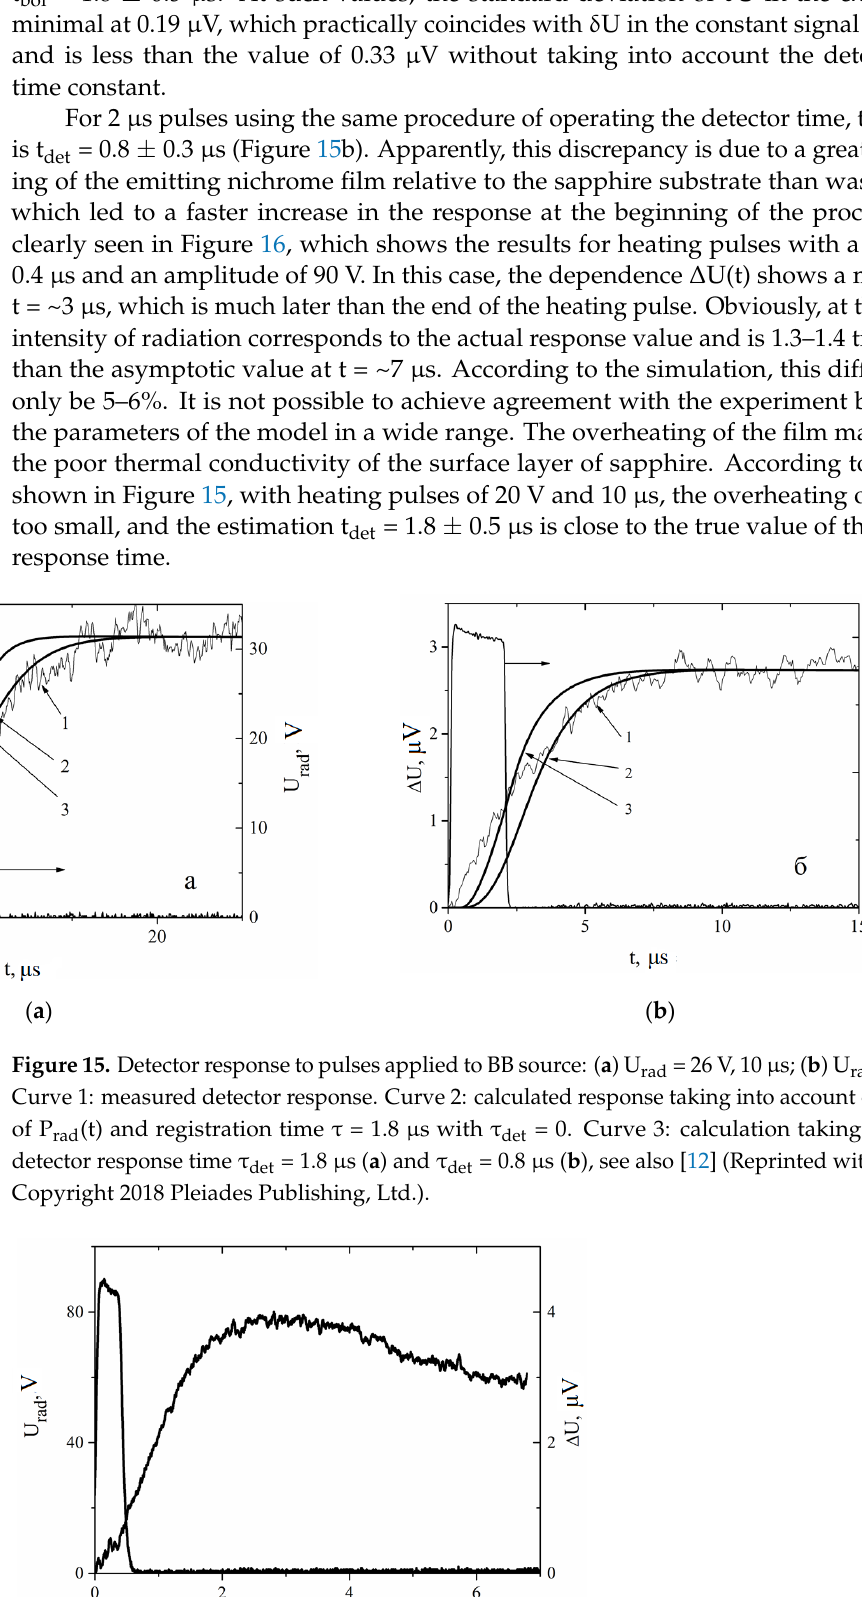
Figure 16. Detector response for pulse amplitude U rad = 90 V, duration 0.4 μ s, applied to BB radiator.